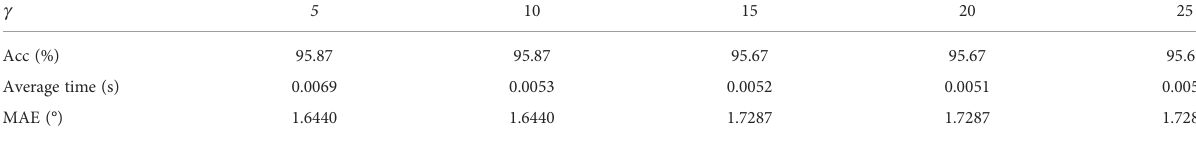
TABLE 4 The DCMP algorithm performance under differentvalues of g for two sources, the SNRof 20 dB, a 12-element array, 96 snapshots, and h =5